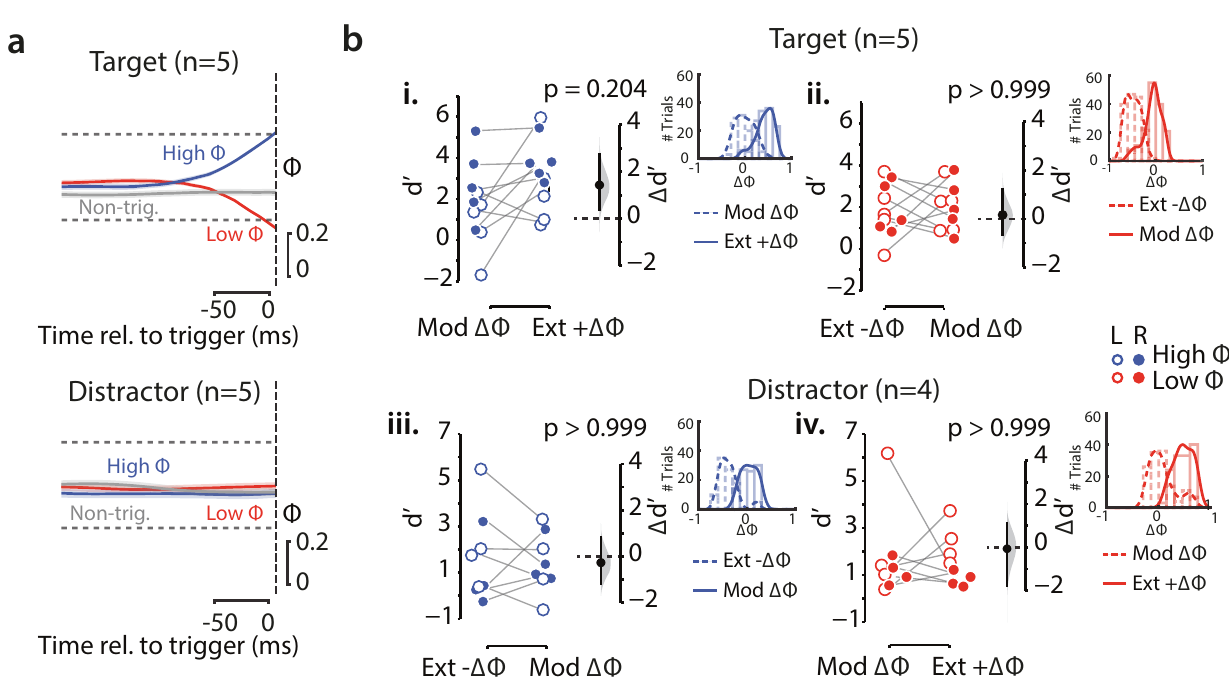
Fig. 3 Effect of difference of SSVEP power across hemi fi elds ( ΔΦ ) on target d ′ . a Mean target Φ (top) and distractor Φ (bottom) traces for high- Φ (blue) and low- Φ (red) target triggered trials, as well as non-triggered trials (gray), time-locked to the presentation of the grating stimuli (dashed vertical line). Shaded region: s.e.m. b (i) d ′ values (dots) based on a median split of ΔΦ for high- Φ , target side triggered trials. Extreme (Ext) + ΔΦ and moderate (Mod) ΔΦ refer to ΔΦ values greater than and less than the median, respectively. Open and fi lled circles: Trials triggered based on left- and right-hemi fi eld Φ values, respectively. Black dot and error bar: Mean effect size and 95% con fi dence interval, respectively, for the difference between d ′ across Ext + ΔΦ and Mod ΔΦ trials. Gray histogram: bootstrap sampling distribution for effect size. Dashed horizontal line: Datum indicating zero effect size. (Inset) ΔΦ distribution for Extreme + ΔΦ (light, solid line) and Moderate ΔΦ (light, dashed line) subsets for high Φ trials. Dark lines: Curve fi ts based on a kernel density estimate. (ii – iv ) Same as in the top left panel, but showing median split results for low- Φ target side triggered trials, high- Φ distractor side triggered trials and low- Φ distractor side triggered trials,